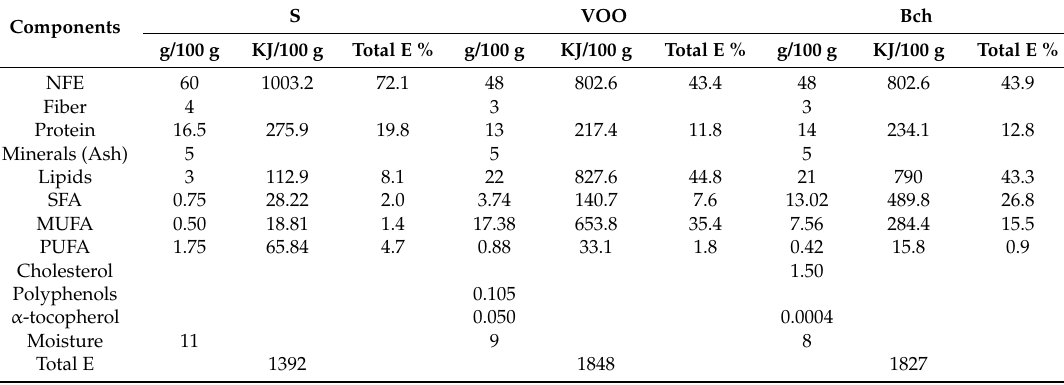
Table 2. Nutritional value and lipid profile of diets used during the study: S (standard chow